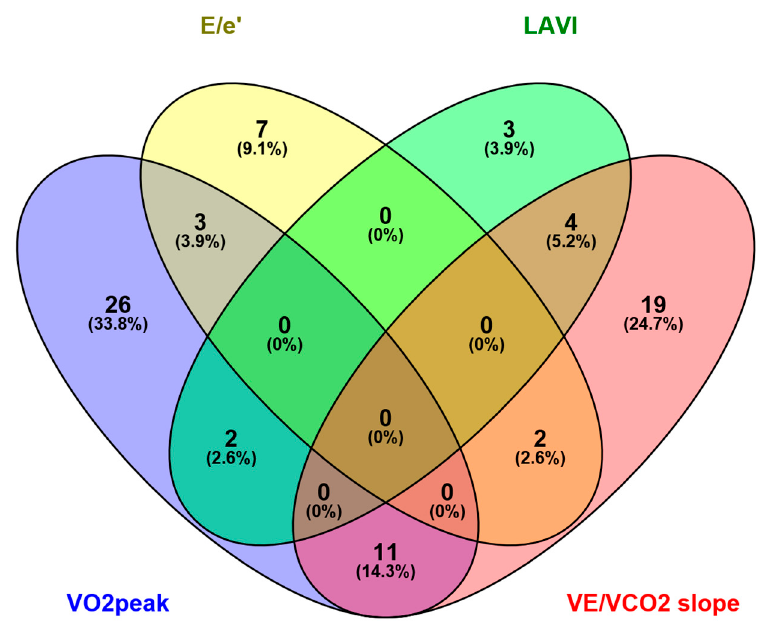
Figure 1. Association of baseline metabolome with changes in outcome parameters after exercise training. The Venn diagram displays the total number of metabolites associated with the four outcome parameters, VO 2 peak, VE / VCO 2 slope, ratio of transmitral Doppler early filling velocity to tissue Doppler early diastolic mitral annular velocity (E / e’) and left atrial volume index (LAVI). The number in the sections where two or more ellipses overlap provide the total number of metabolites associated with two or more outcomes.